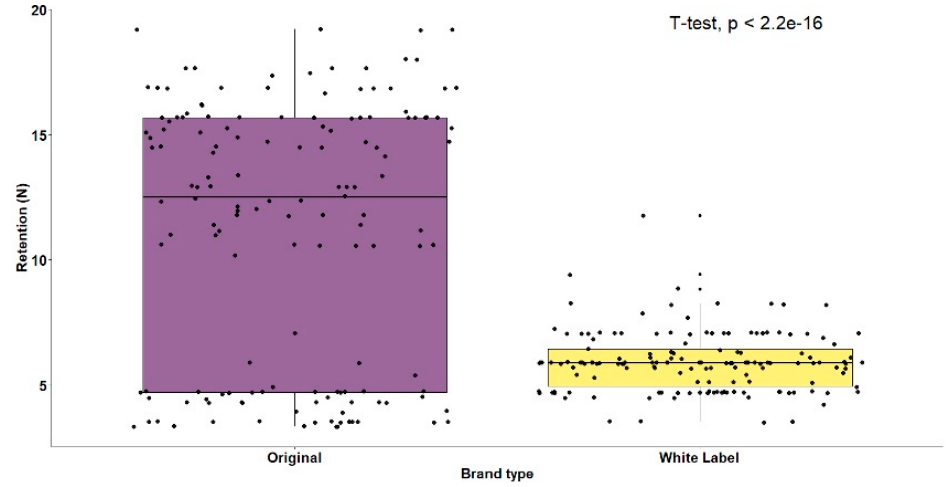
Figure 5. Boxplots for adhesive retention by type of brand.